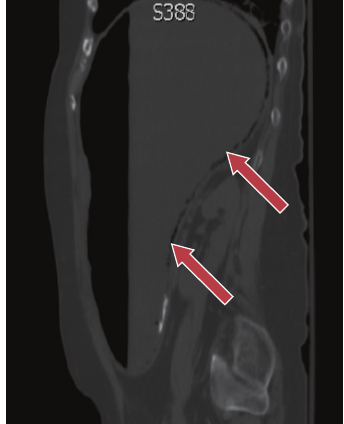
Figure 2: Gastric emphysema on CT scan, coronal reformat (arrows).